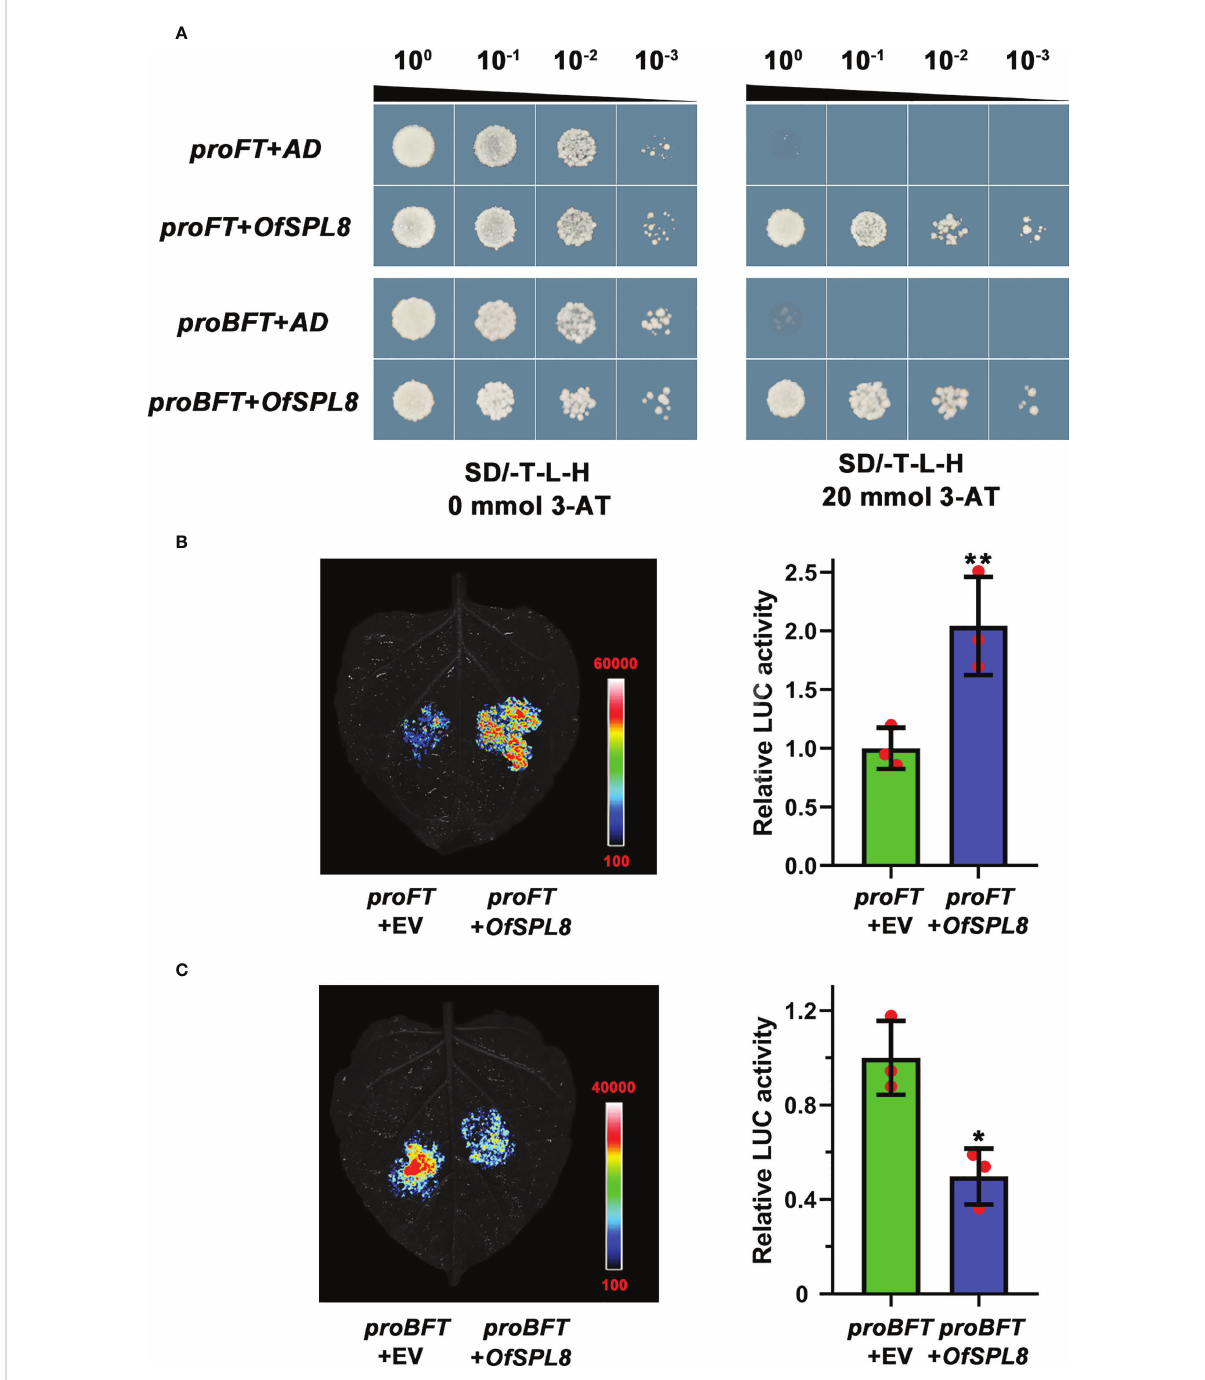
FIGURE 8 The binding between OfSPL8 , proOfFT , and proOfTFL1 . (A) Yeast one-hybrid analysis of proOfFT , proOfBFT , and OfSPL8 . (B) Dual-LUC analysis of proOfFT and OfSPL8 . Student ’ s t test means ± SD, n = 3, ** p < 0.01. (C) Dual-LUC analysis of proOfBFT and OfSPL8 . Student ’ s t test means ±SD, n = 3, * p <